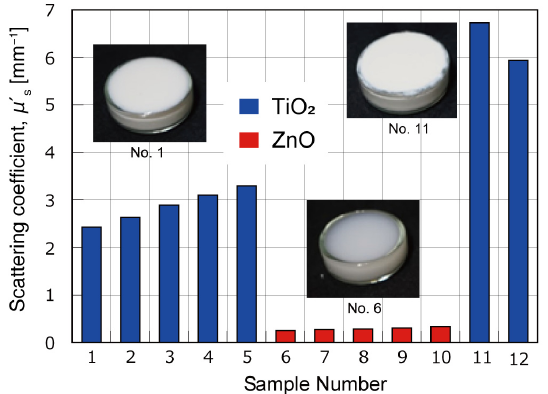
Figure 8. Measurement results for all samples used in the sensory